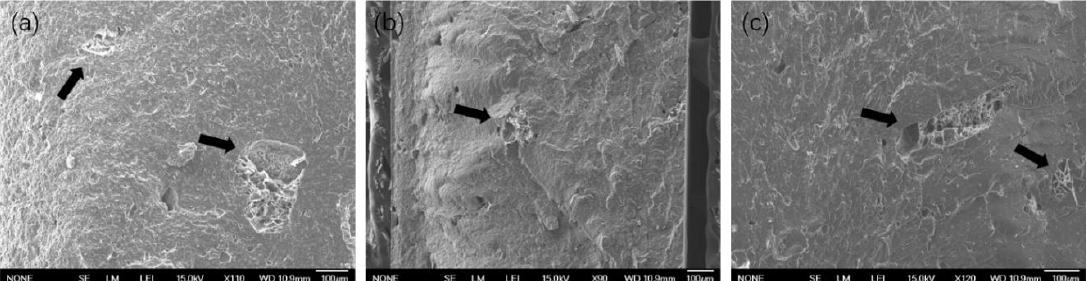
Figure 10. SEM spectra of degradation structure in ( a ) PHS_UP for 588-h release, ( b ) PBHS 30/70_UP